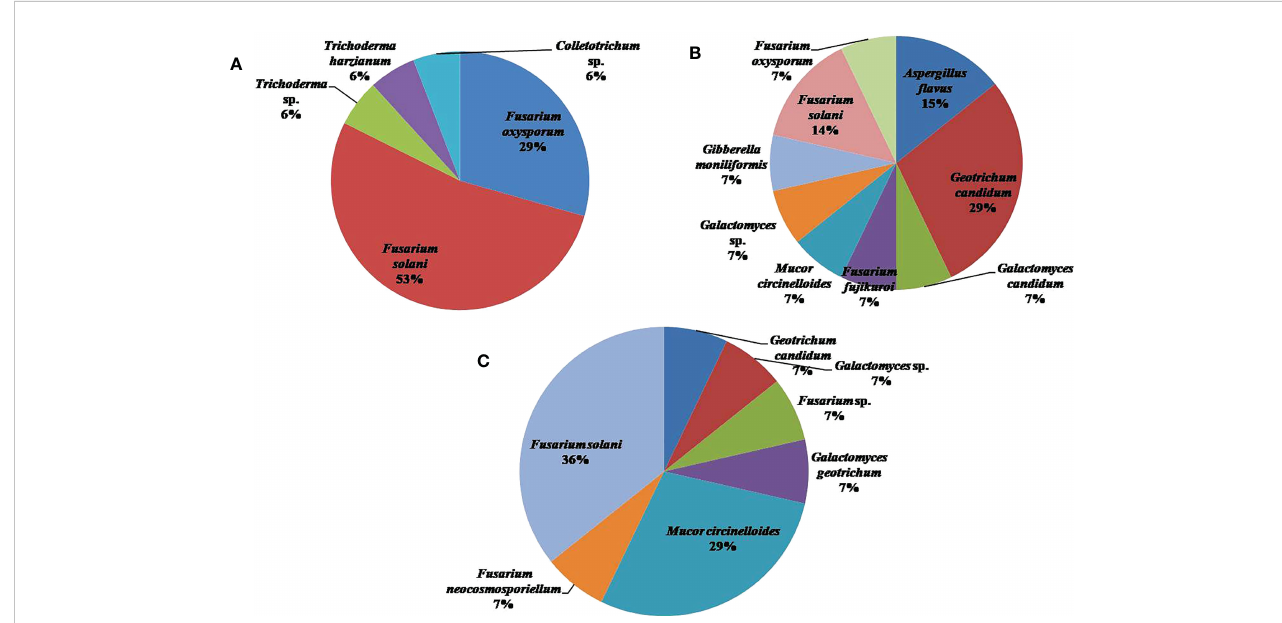
FIGURE 5 Pie chart representing the distribution and diversity of fungal species in (A) Srinagar, (B) Kishtwar, and (C)